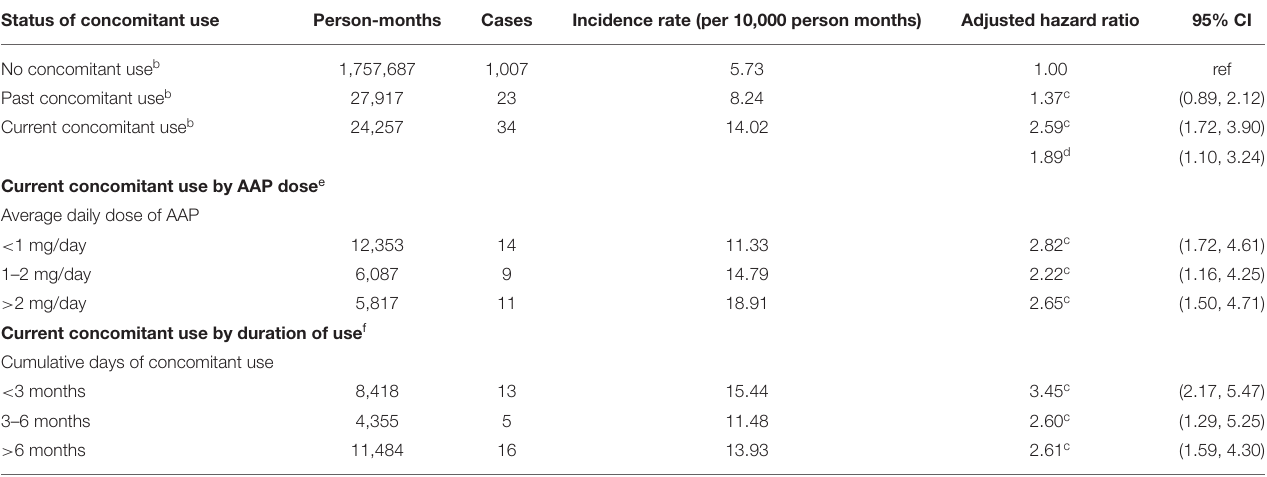
TABLE 2 | Incidence rates and hazard ratios of less severe cardiovascular risk comparing concomitant use of antipsychotics and stimulants with only stimulant use a